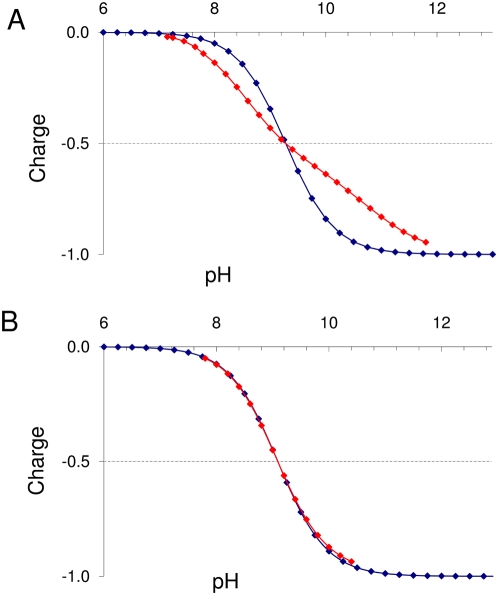
Theoretical titration curves.The calculated curves are shown in red and the corresponding standard
Henderson-Hasselbach (HH) titration curves in blue. (A) An example of a
highly deviating theoretical titration. (B) An example of no deviation
(this is the most common situation since most Cys behave in this
manner).